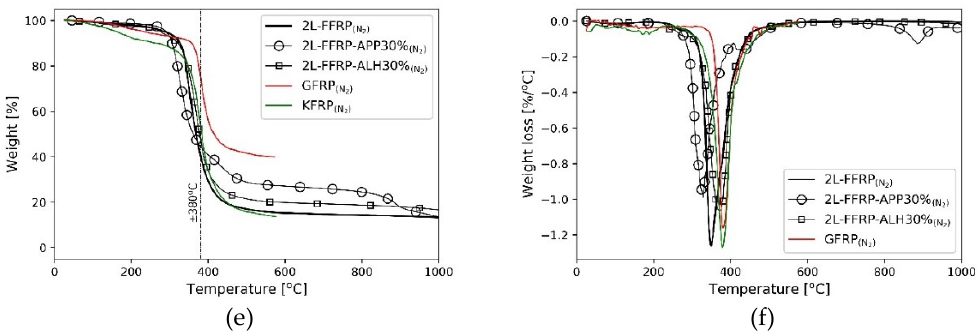
Figure 4. TGA and DTG curves of fire retardant FFRP composites: ( a,b ) ammonium polyphosphate (APP); ( c,d ) aluminium hydroxide (ALH); and ( e,f ) comparison to kenaf and glass fibre-reinforced polymer [47].